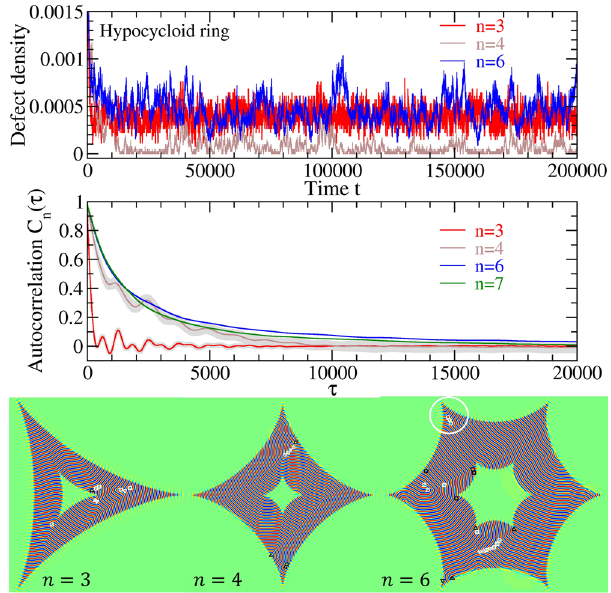
Fig. 8 Defect density and time correlation for hypocycloid rings. Sample time evolution of defect number density and the results of autocorrelation C τ ) (each averaged over 80 runs for t = 10 5 – 10 6 with system grid size n ( 512 × 512) for various hypocycloid rings at v 0 = 0.31. Sample snapshots of the ψ fi eld spatial pro fi le are also shown, with the white-circled region corresponding to the local defect trapping near a cusp of n = 6 hypocycloid ring as seen in Supplementary Movie